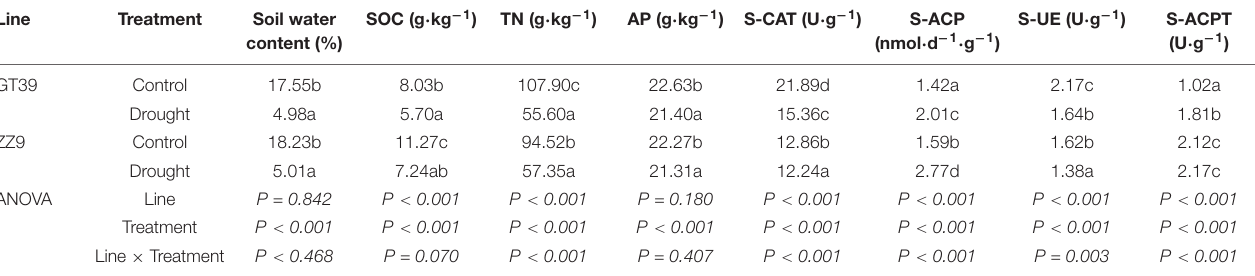
TABLE 1 | Physical and chemical properties of soil under different treatments. Line Treatment